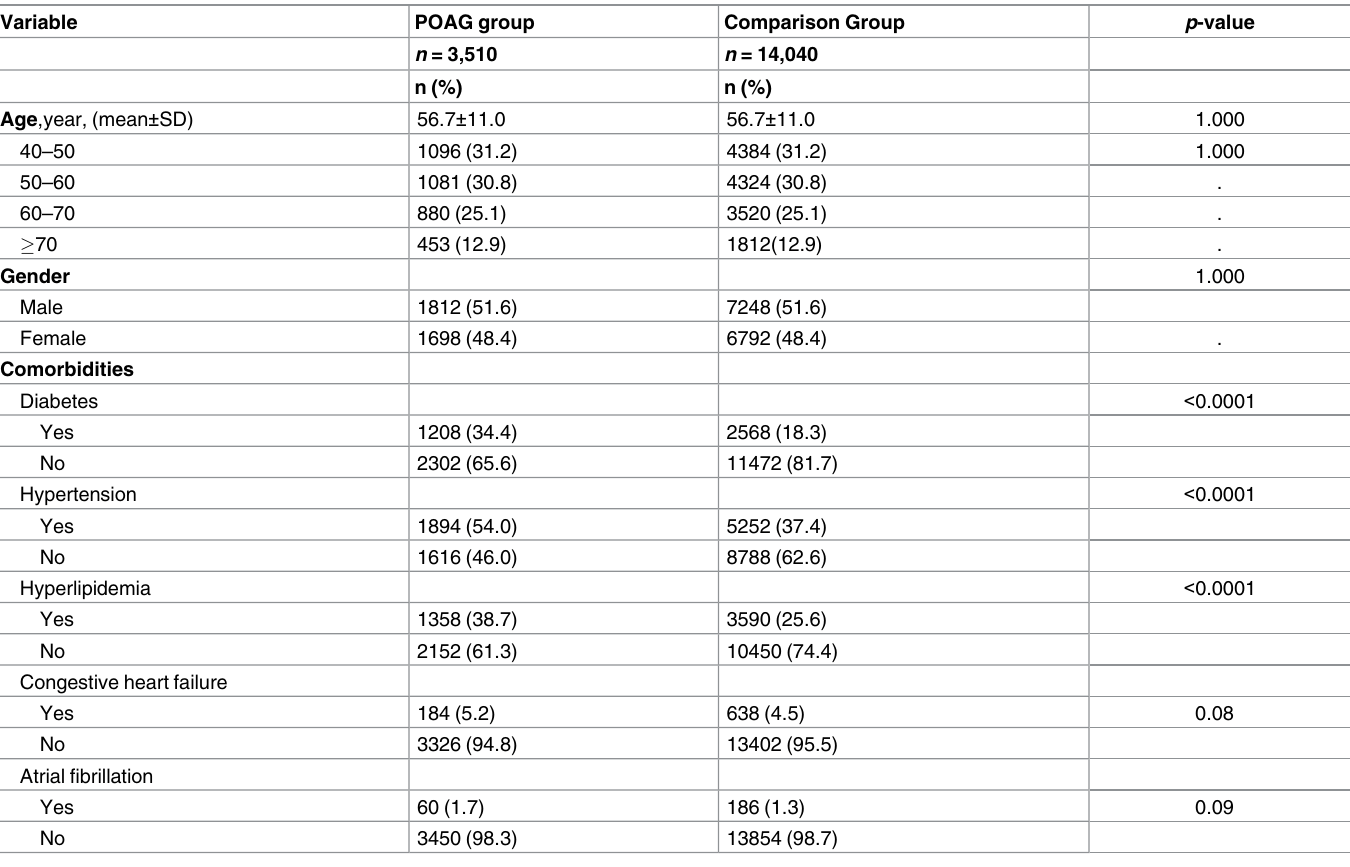
Table 1. Characteristics of study